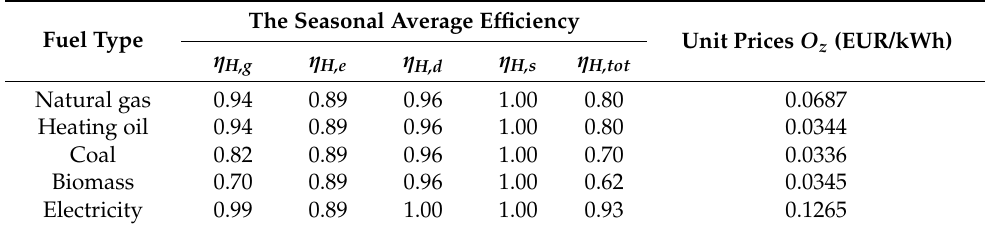
Table 7. The seasonal average efficiency of the heating system [18] and unit price of 1 kWh of thermal energy for various fuel types (own elaboration based on [24–26]).